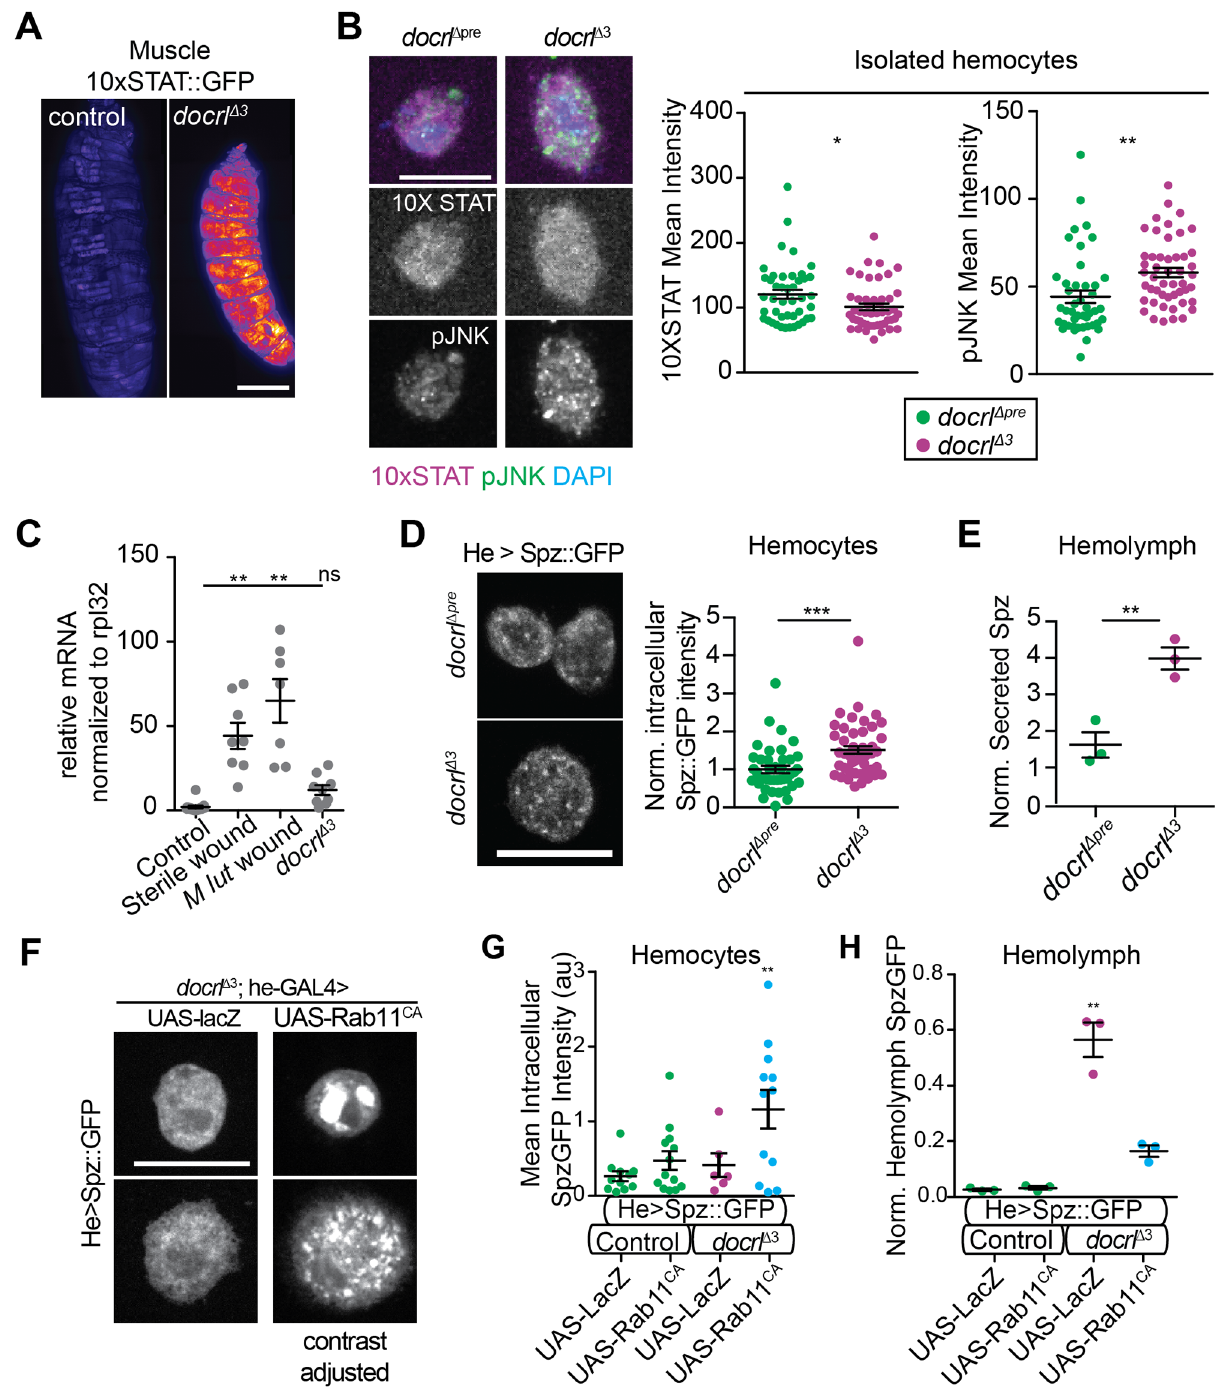
Fig 8. Loss of docrl activatesmultiple immune-relevant signaling pathways. (A) Jak/STAT reporter 10X STAT-GFP is inducedin docrl mutant muscle tissue. (B) Loss of docrl inducesphospho-JNK(green) but not 10X STAT reporter (magenta) in isolatedhemocytes (quantifiedin adjacent graphs). (C) qPCR shows that Toll target Drs is not upregulatedin docrl Δ 3 larvae as comparedto sterile or M . luteus woundedanimals. (D) Spz-GFP accumulation (gray) is mildly, but significantly increasedin docrl Δ 3 mutant hemocytes. Images show 2D confocalprojectionsof fixed hemocytes. (E) Secreted Spz-GFP is increasedin docrl Δ 3 hemolymph, measured by western blot of cell-free hemolymph(see blot in S8D Fig). (F) Hemocyte-specific expressionof Rab11 CA causes strong Spz-GFP accumulationin docrl Δ 3 mutant hemocytes (quantifiedin G). Images show 2D confocal projections of fixed hemocytes, top and bottom panels are two examplecells of each genotypeto show the range of typical Spz-GFP intracellulardistribution;Rab11samples are contrast-adjustedrelative to controls.